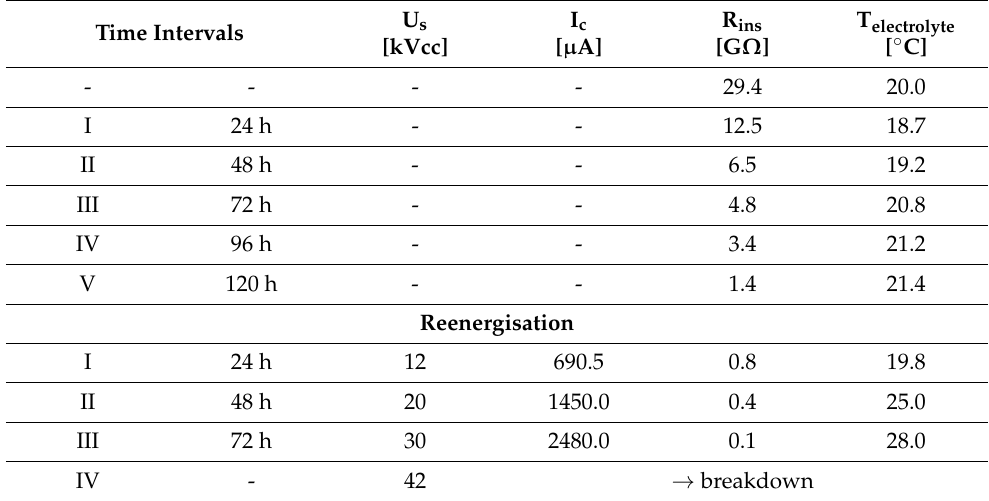
Table 2. Constant measured size values in the second stage of the experimental